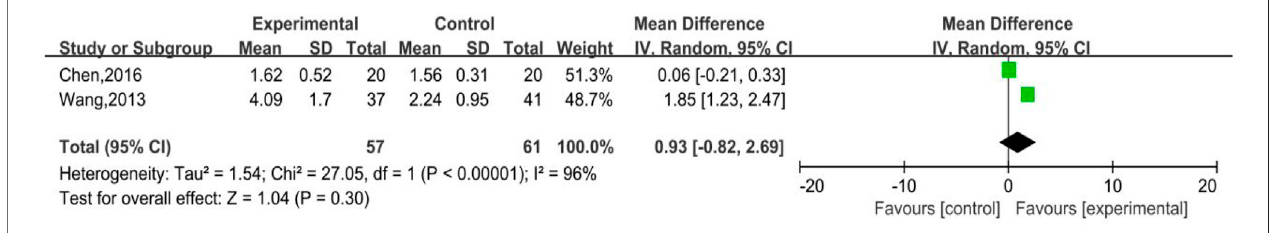
FIGURE 13 | The forest plot of neutrophile count in therapeutic medication.